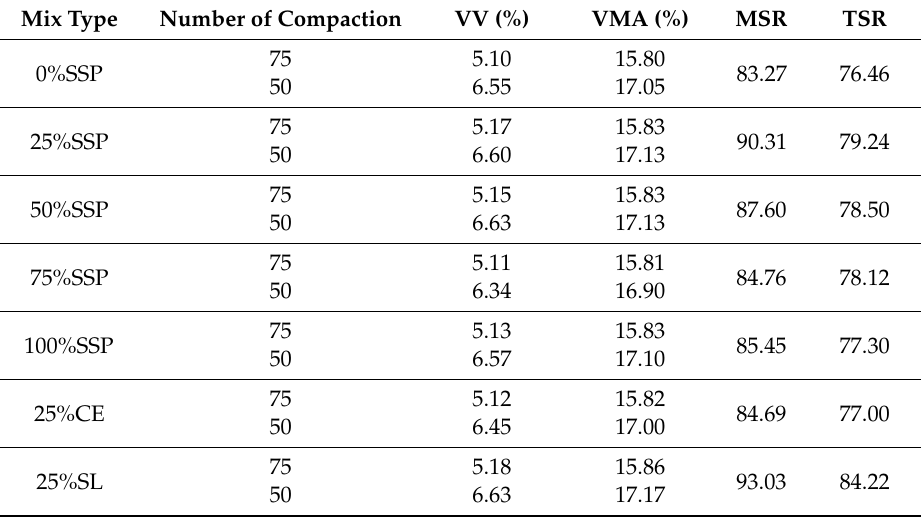
Table 6. Water resistance results and volumetric properties of di ff erent type of